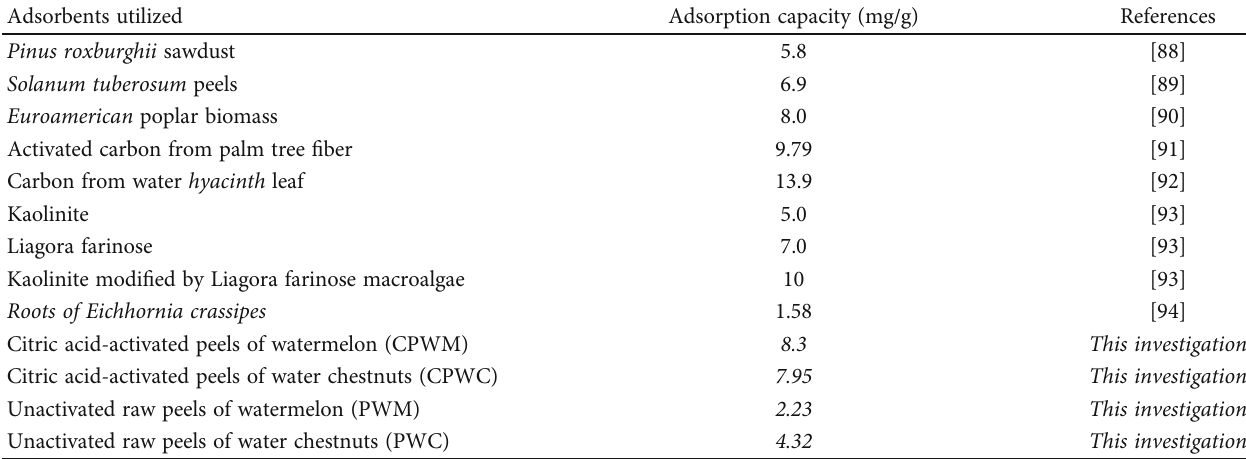
Table 1: A comparison of the adsorption capacity of adsorbents with previous reported research work.